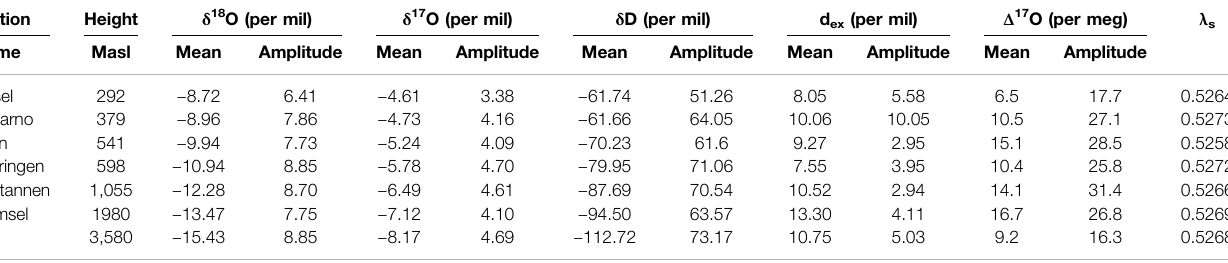
TABLE 1 | Measured monthly means and monthly mean amplitudes for seven stations of the Swiss ISOT network. λ s is calculated based on ln ( R 17 s / R 17 r ) to ln ( R 18 / R 18 ) plots. s r